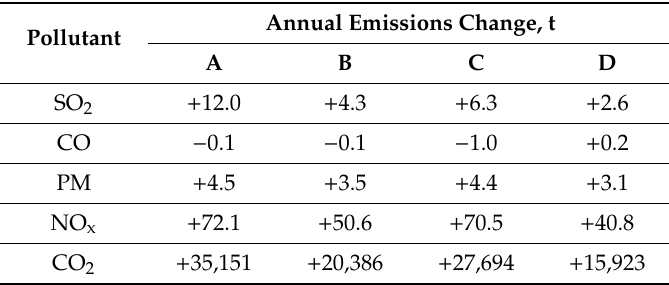
Table 12. Total pollutant balance, taking into account the electric energy cogenerated in the CHP unit in Scenarios A to